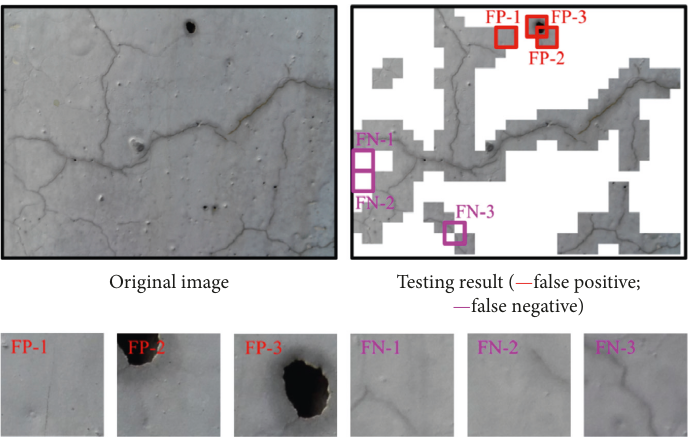
Figure 13: Complex and blurry